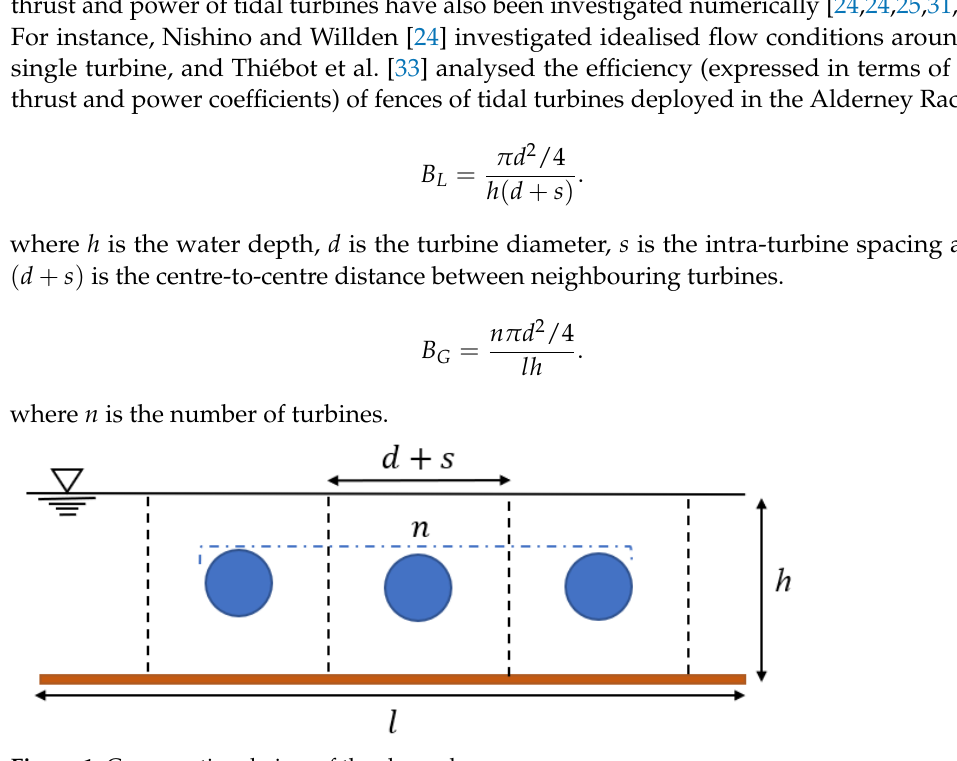
Figure 1. Cross-sectional view of the